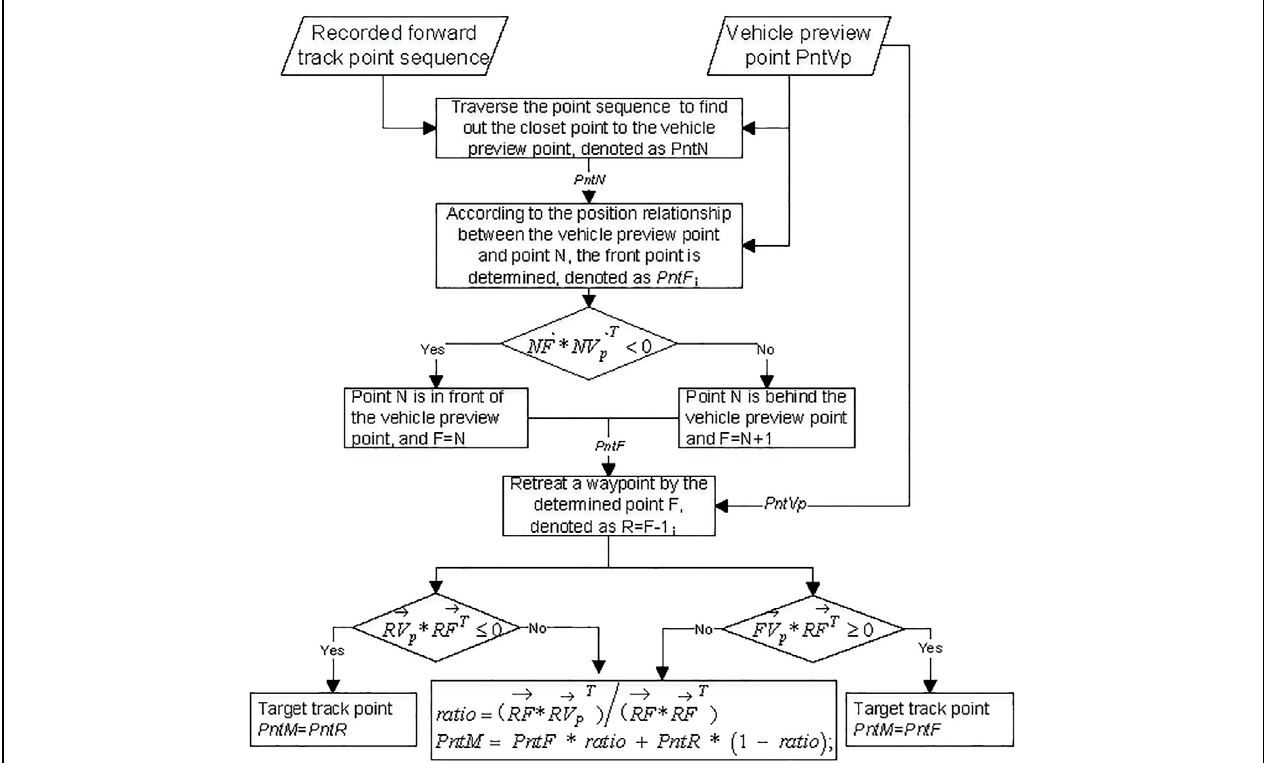
FIGURE 7 | Calculation process of the target tracking point.